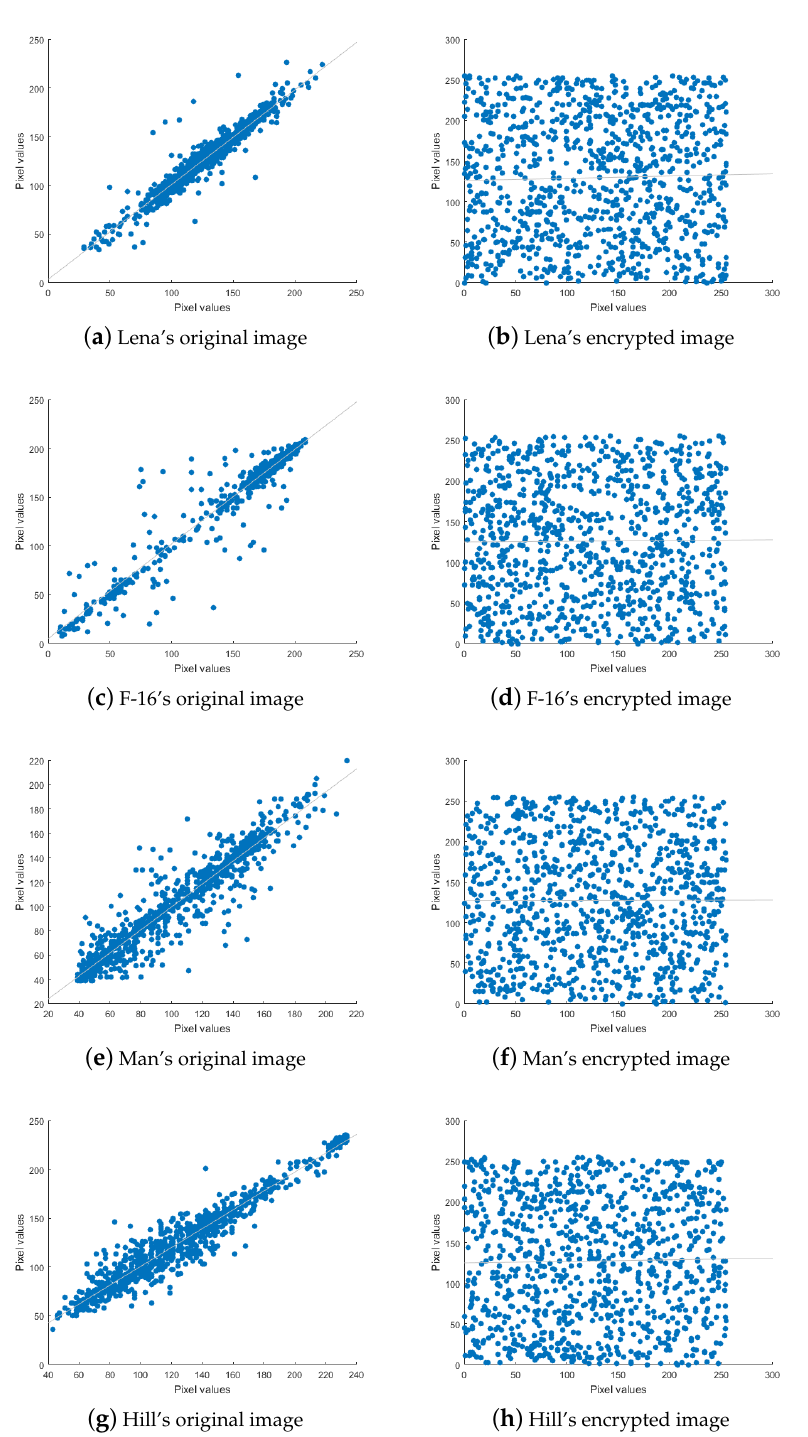
Figure 9. Horizontal adjacent pixel correlation scatter plot of the images in Figure 6a,b,f,g,k,l,p,q. The information entropy of the image can measure the distribution of the gray value. The result shows that the larger is the information entropy, the more consistent is the gray distribution. For an ideal random image, the information entropy is equal to 8. In Table 6, the experimental results confirm the conclusion of theoretical analysis. Below, we briefly prove it. Theorem 2. For information entropy H, there is H ( m ) ≤ 8